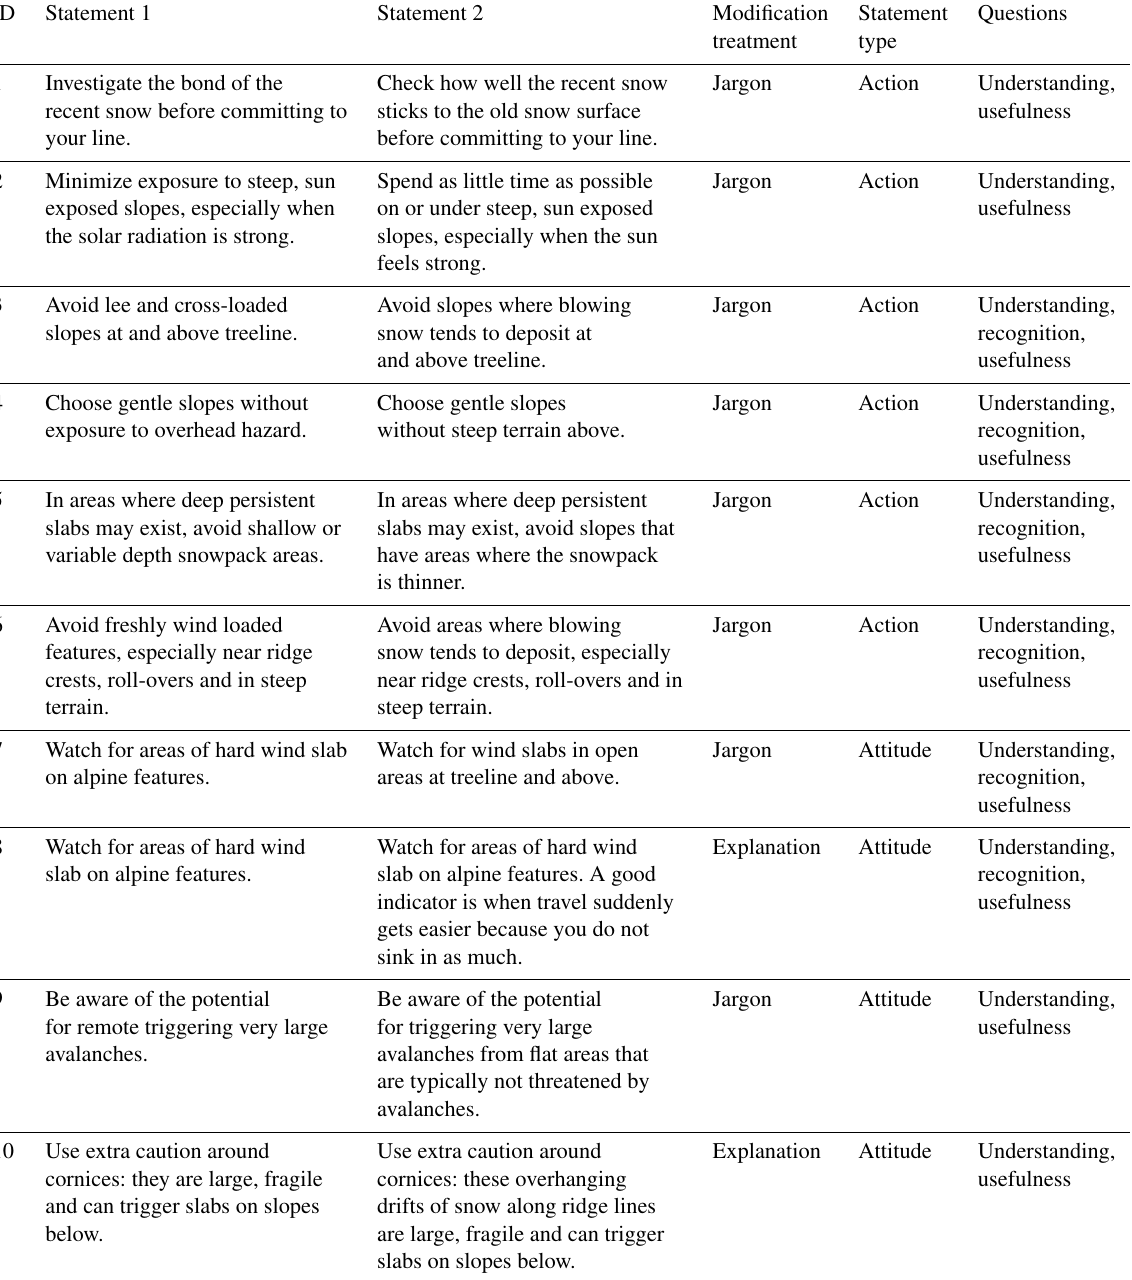
Table A1. Travel and terrain advice statements used in the